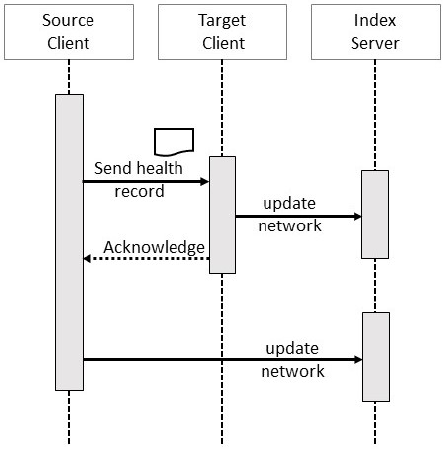
Figure 3. Push Operation. This operation is used by either the patient or the health provider to update the health record maintained by the other party.